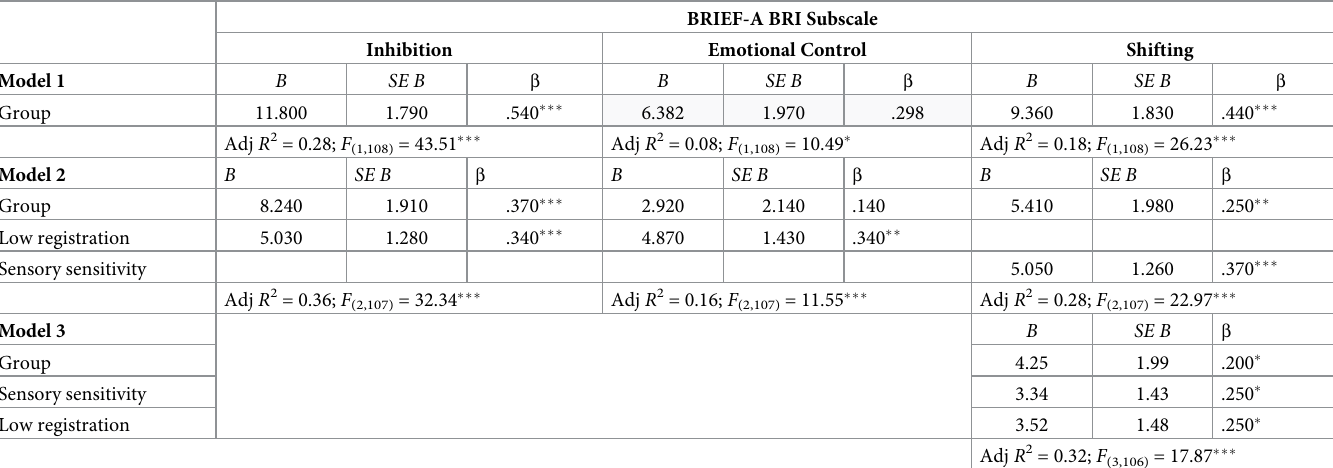
Table 3. Predicting each BRIEF-A BRI subscale score by AASP sensory pattern scores above group membership.